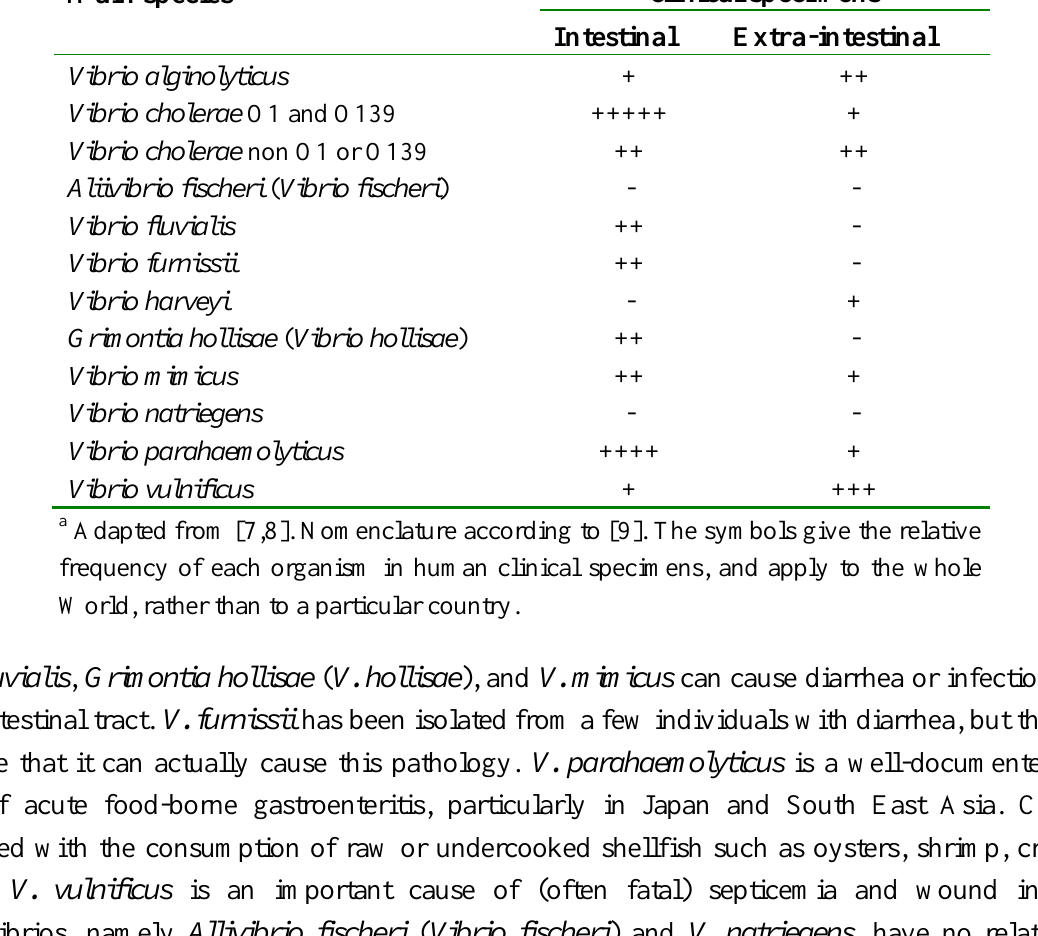
Occurrence in human clinical specimens Intestinal